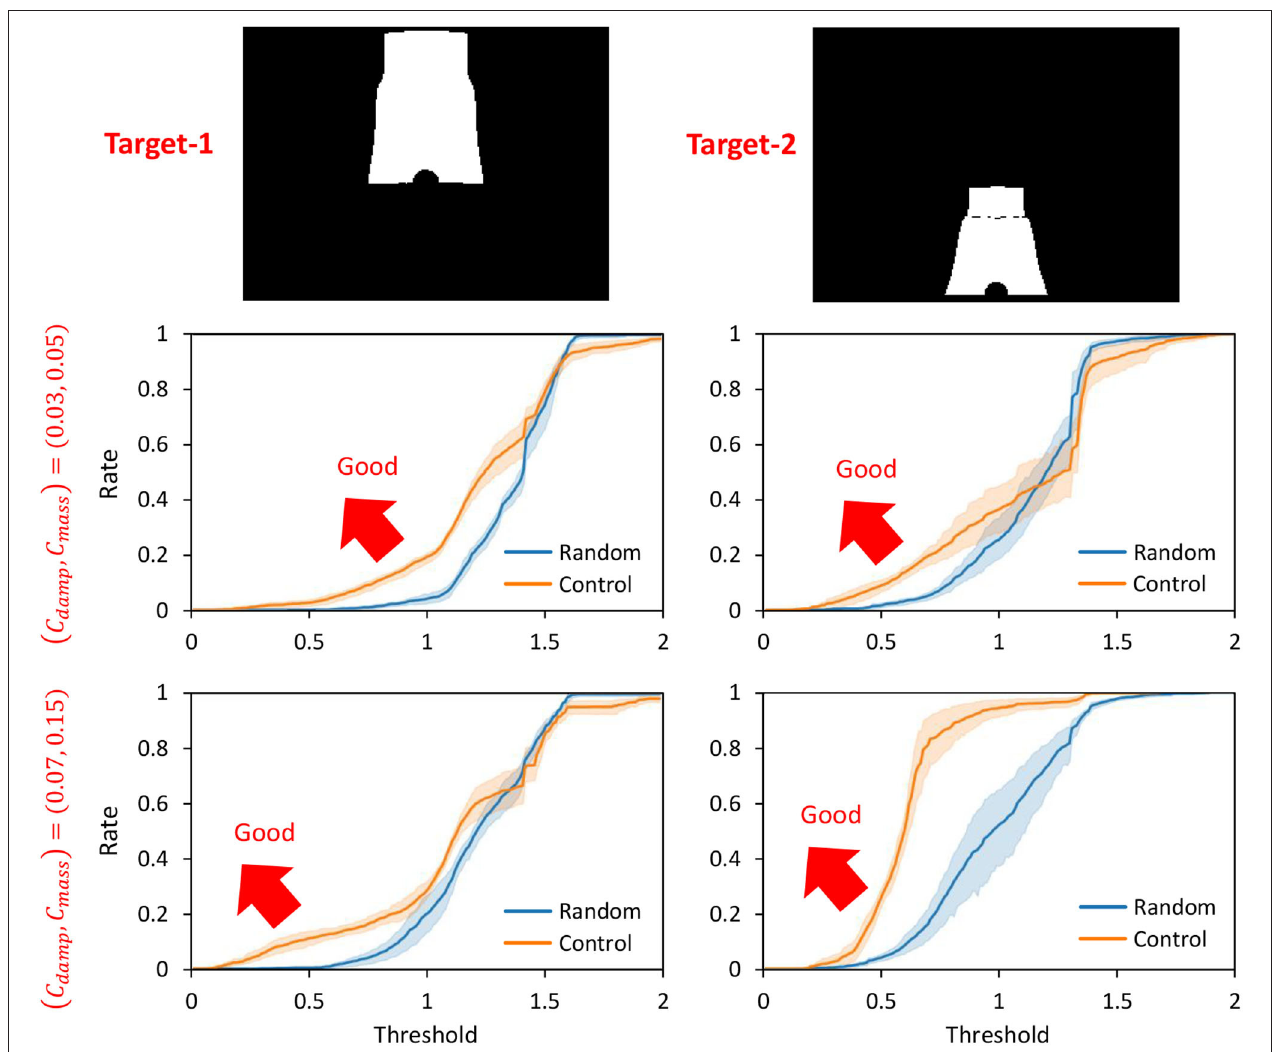
FIGURE 6 | Simulation experiment: the rate (y-axis) of || z ref − z || 2 < threshold (x-axis) when conducting experiments of dynamic manipulation of two cloths Target-1 and Target-2 when setting ( C damp , C mass ) = { (0.03,0.05),(0.07,0.15) } regarding Control and